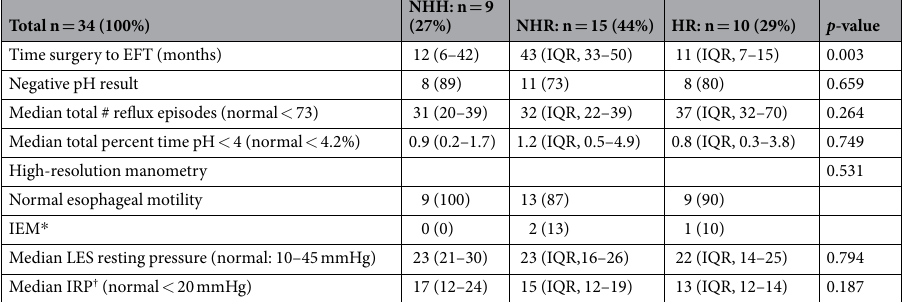
Table 2. Results of postoperative esophageal functioning testing (EFT). Error analysis: standard deviation. Numbers provided in tables are medians (IQR). * IEM = ineffective esophageal motility; † IRP = integrated relaxation pressure of LES.